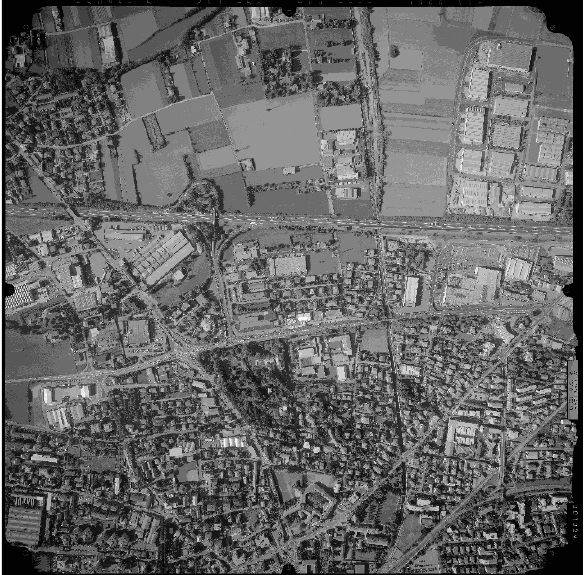
Figure 1. Example of an analogue photo with eight FM’s captured with a Wild RC30 airborne metric camera. This image is included in ‘Test block’ described at the beginning of Section